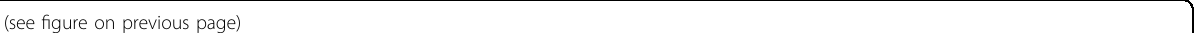
Fig. 3 BSO and DPI cooperatively induced death of oncogenic KRAS -expressing colon cancer cells with or without p53 mutation. A – C qRT- PCR analysis of the expression levels of CYBA (the gene encoding p22phox), GCLC , and GCLM genes in HCT116 + / + and HCT116 − / − cells. β -actin serves as a control. D HCT116 + / + and HCT116 − / − cells were incubated with BSO (100 μ M) alone or DPI alone (0.1 μ M or 1 μ M) for 24 h and cell death was measured by fl ow cytometry using annexin-V and PI as probes. E HCT116 + / + and HCT116 − / − cells were incubated with 0.1 μ M or 1 μ M DPI in the presence of 100 μ M BSO for 24 h. The cell death rate was determined with fl ow cytometry. F Equal numbers of HCT116 + / + and HCT116 − / − cells were seeded in 6-well plates and treated with DPI at 0, 0.01, 0.03, 0.1, 0.3, or 1 μ M in the presence or absence of 100 μ M BSO for 14 days. Cells were stained with crystal violet and photographed. G , H Bar graph presentation of data analysis shown in F . The density of the crystal violet areas in the colonies of either cell line was considered as 1 (100%) for the respective data set. Data are mean ± SD of three independent experiments with Student ’ s t test. * p < 0.05, ** p <